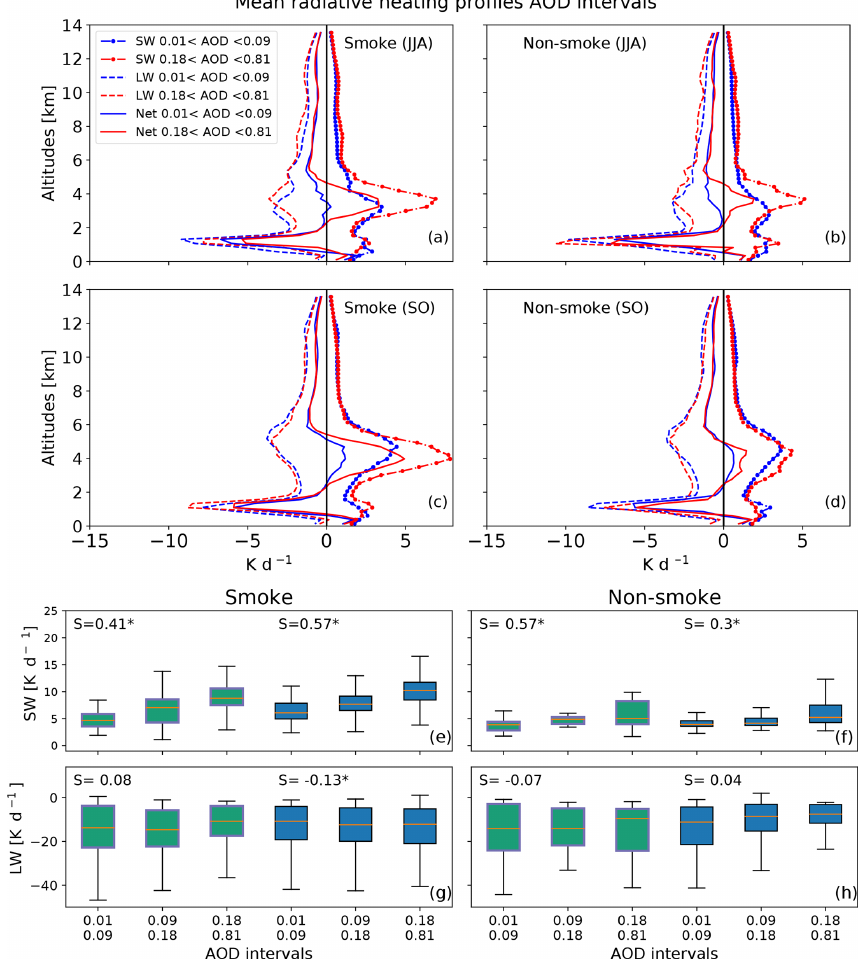
Figure 7. (a–d) Mean shortwave (SW), longwave (LW), and net (Net) radiative heating profiles for the smoke and non-smoke cases with high and low AOD during June–July–August (JJA) and September–October (SO) for the period 2007–2010. (e–h) Box plots of maximum SW heating within the aerosol layer (e, f) and maximum LW cooling at cloud top (g, h) for three AOD intervals for the smoke and non-smoke cases. Green boxes correspond to JJA and blue boxes to SO. For each case and period the Spearman rank correlation coefficient ( S ) between the full range of AOD values and the SW (or LW) fluxes appears on top. Significant correlations (with p value < 0 . 05) are marked with a star ( ∗